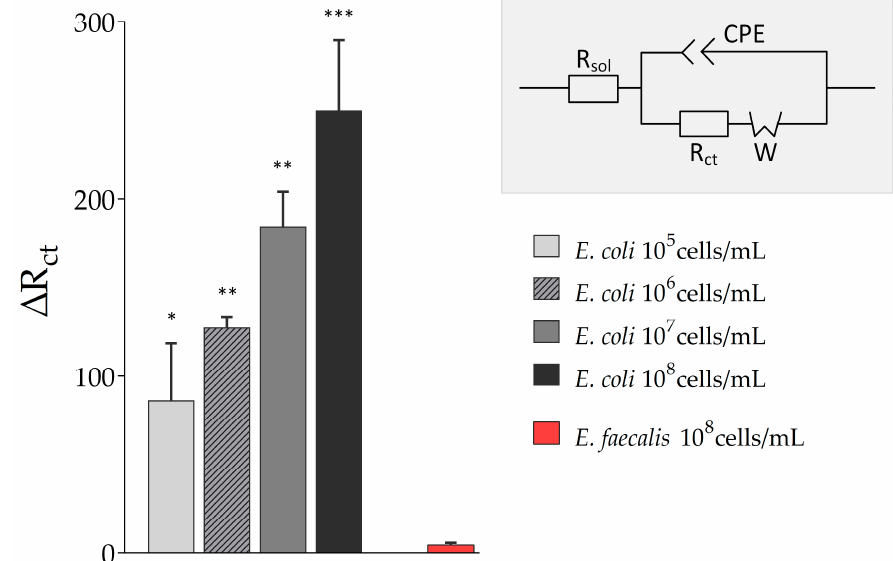
Figure 5. Results of biosensing experiments. Electrochemical Impedance Spectroscopy (EIS) measurements of biosensor experiments with varying Escherichia coli Crooks and Enterococcus faecalis (E. faecalis) concentrations were fitted to the modified Randles circuit with R sol : solution resistance, R ct : charge-transfer resistance, W: Warburg impedance, and CPE: constant phase element. Extracted charge transfer resistance ∆ R ct is displayed. All experiments were repeated several times in independent experiments (technical replicates, n = 3) and significant differences to Enterococcus faecalis as a control are indicated: * p < 0.05, ** p < 0.01, *** p < 0.001.